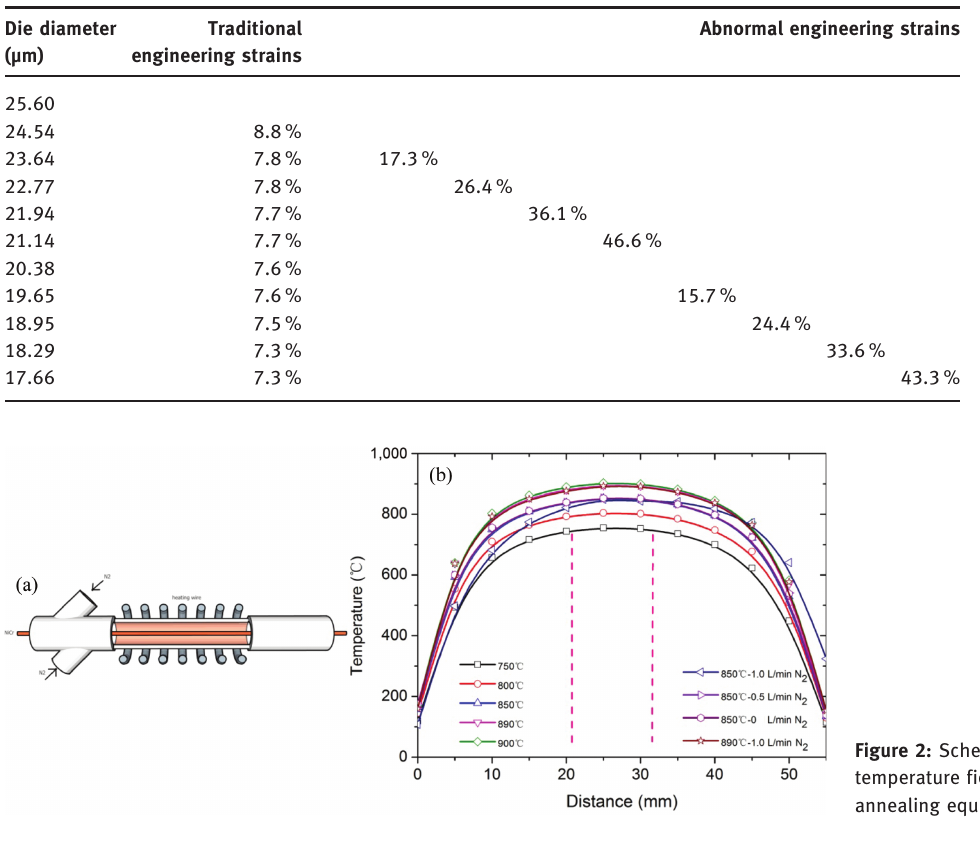
Table 1: The traditional engineering strain and abnormal engineering strains. Die diameter